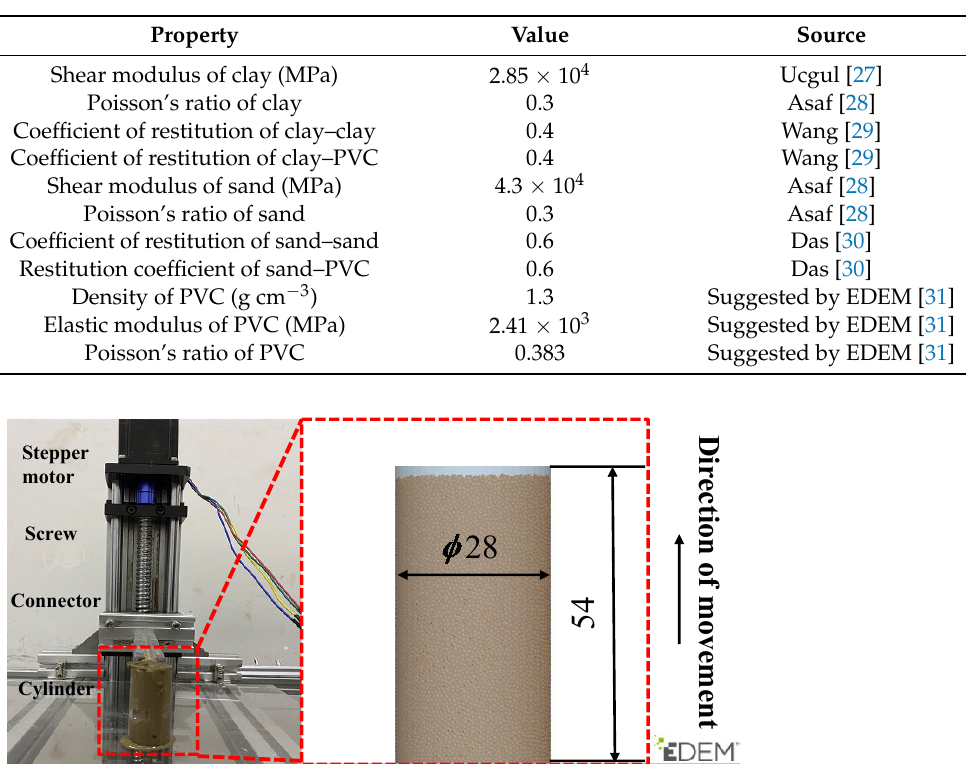
Table 2. DEM parameters used in the simulations.